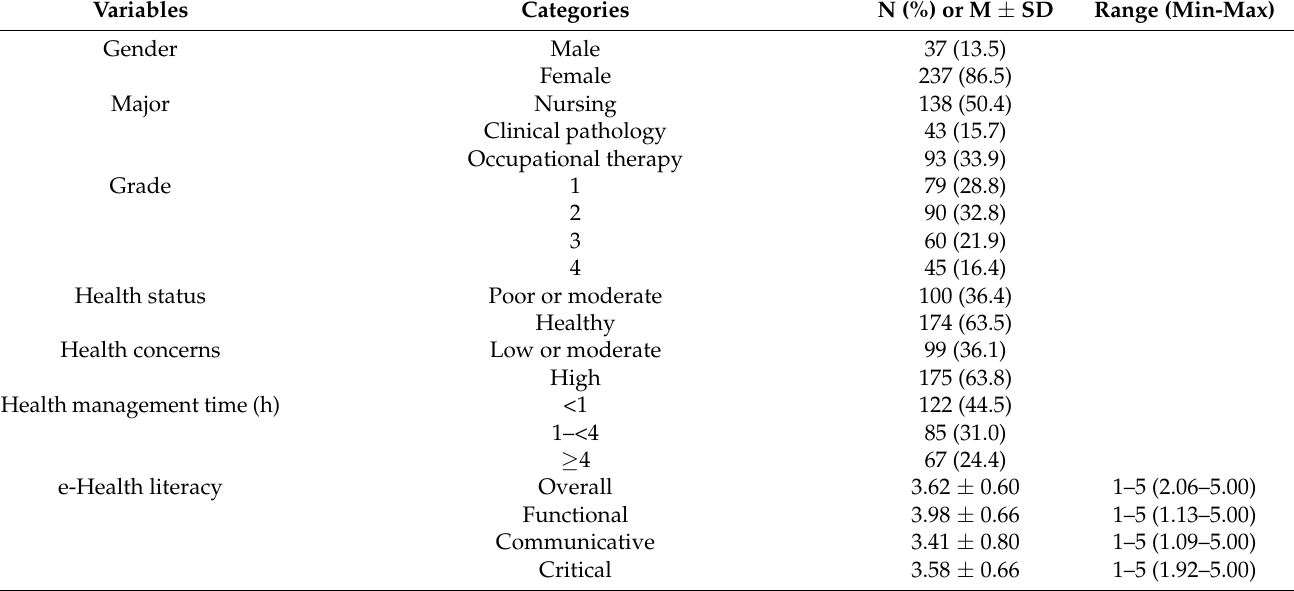
Table 1. Characteristics of participants and the level of e-HL and infection-preventive